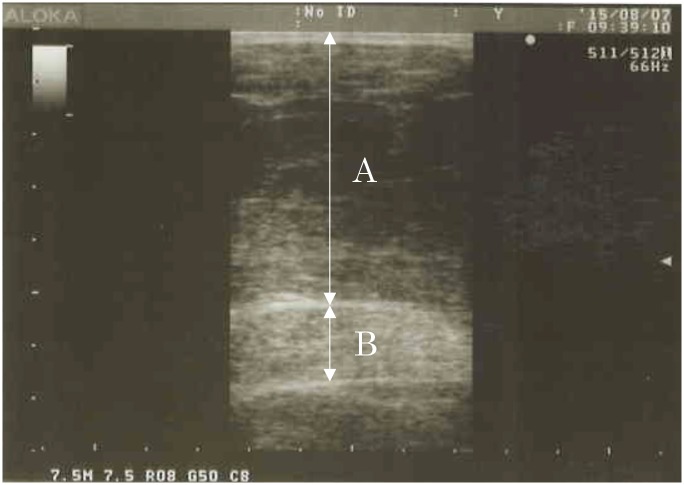
Typical abdominal ultrasound image in obesity patient.The thickness values of the muscle tissues was determined as the distances between the skin and fat—muscle tissue interface and between the fat—muscle tissue interface and muscle—abdominal cavity boundary. (A) Subcutaneous fat thickness, (B) Muscle thickness.